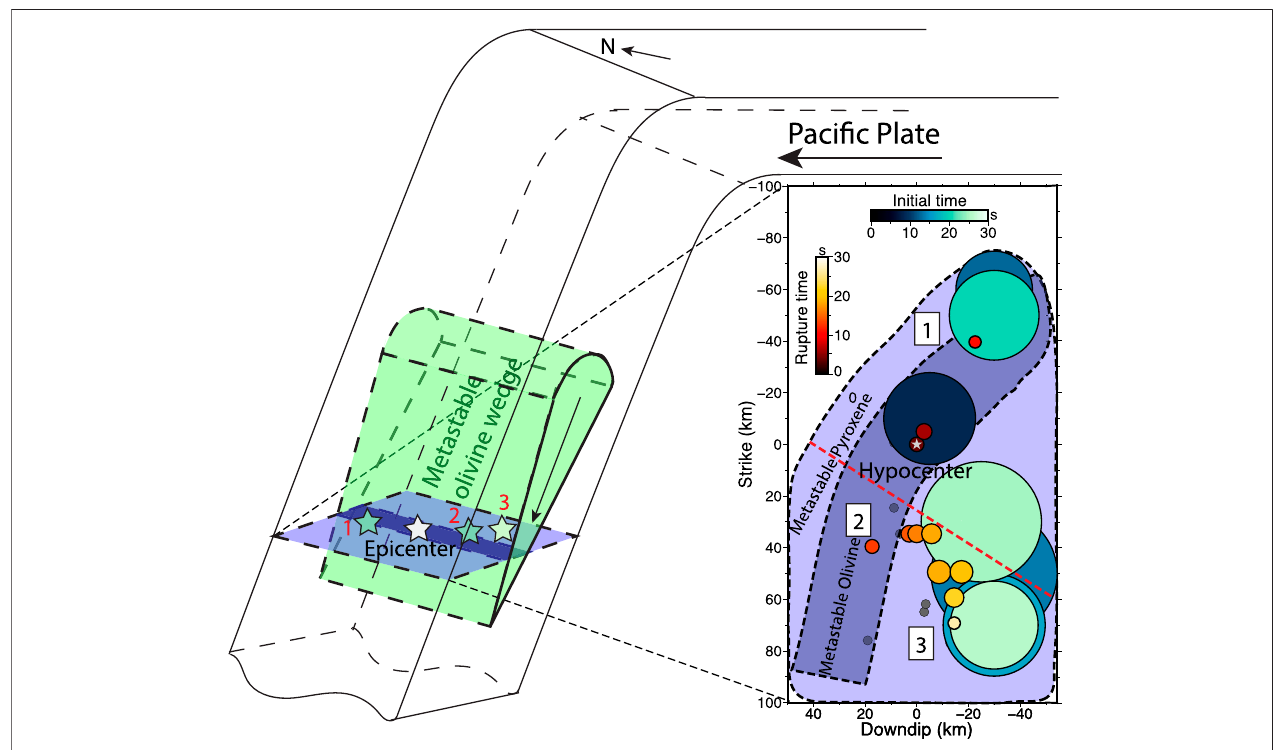
FIGURE 8 | Schematic diagram illustrating the rupture of the 2013 Okhotsk earthquake outside the possible metastable olivine wedge (dark purple) but inside the metastablepyroxenewedge(lightpurple)(Bina,2013).Threerupturesegmentsarelabeled1,2,and3respectively.(Inset)Overlapthe fi nalback-projectionandinversion models with the possible MOW and metastable pyroxene wedge (MPW). Numbers one to three depict the fi rst, second, and third rupture segments, respectively. Dark purple area denotes the MOW, and the light purple area indicates the MPW. The red dashed line just crosses the slab.